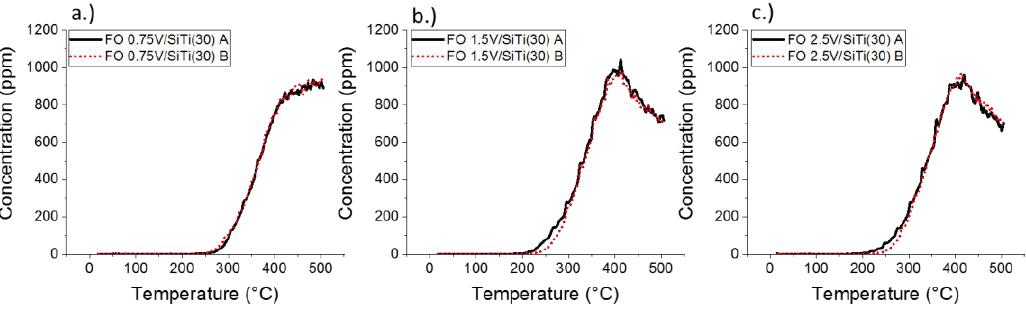
Figure 9. Formation of formaldehyde of the repeated tests for ( a ) 0.75V/SiTi(30); ( b ) 1.5V/SiTi(30) and ( c ) 2.5V/SiTi(30) (feed 500 ppm MeOH + 500 ppm MM, heating rate of 5°C min −1 , A referring to test 1 and B referring to the repeated test 2).